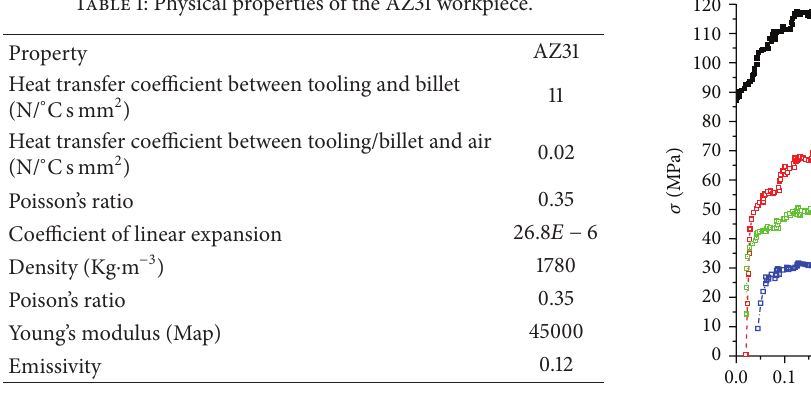
Table 1: Physical properties of the AZ31 workpiece.